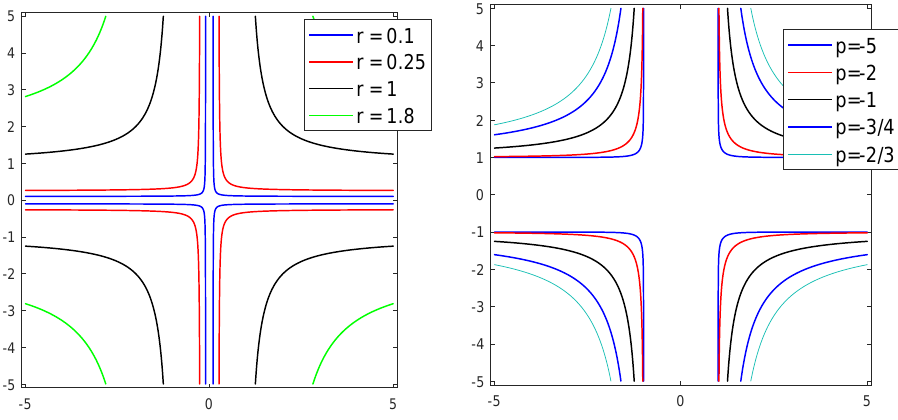
Figure 4. Level r lines of the semi-antinorm z → | z | − 1 and level one lines of the semi-antinorms | z | p